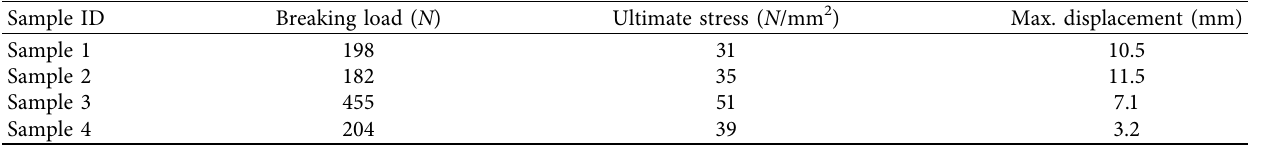
Table 5: Flexural test result.